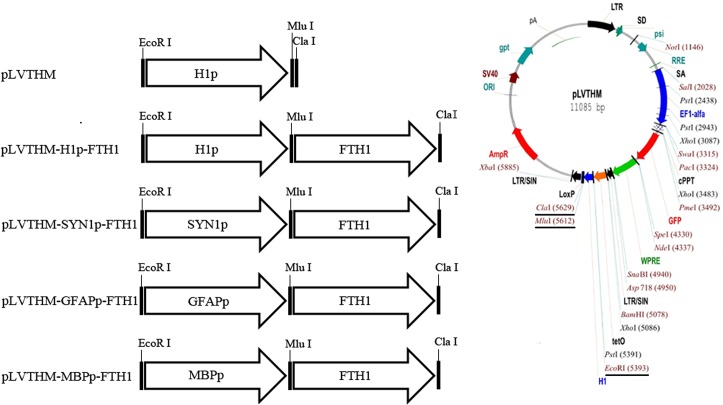
Outline of lentiviral vector construction.Ferritin-expressing lentiviral vectors were constructed in two steps. First, the FTH1 sequence was cloned into the pLVTHM vector between the MluI and ClaI sites, downstream of the H1p promoter, generating the pLVTHM-H1p-FTH1 plasmid vector. Second, one of three neural cell-specific promoter sequences (SYN1p, GFAPp, or MBPp) was cloned into the pLVTHM-H1p-hFTH1 vector between the EcoRI and MluI sites, replacing the H1p sequence, to generate three NDIFE vectors: pLVTHM-SYN1p-FTH1, pLVTHM-GFAPp-FTH1, and pLVTHM-MBPp-FTH1. FTH1: ferritin heavy chain, SYN1: synapsin I, GFAP: glial fibrillary acidic protein, MBP: myelin basic protein.